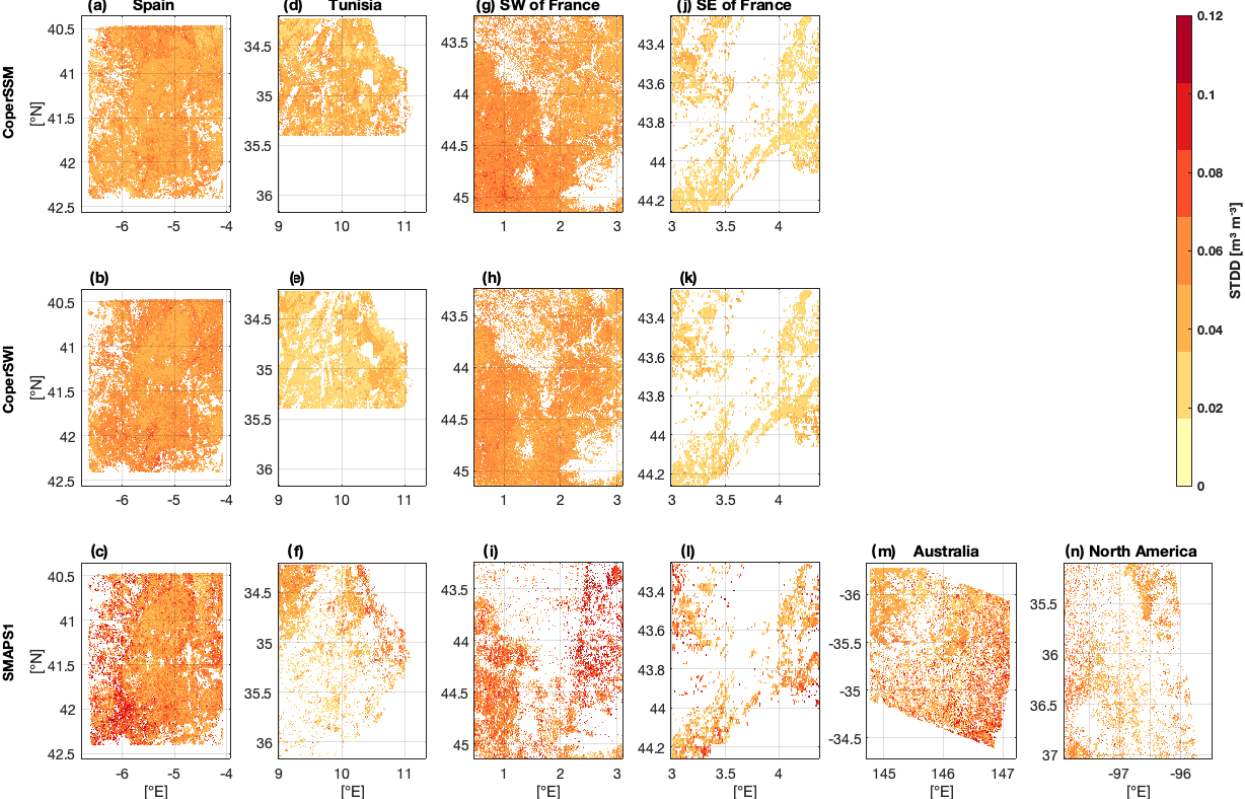
Figure 6. Comparison of S 2 MP S1S3 with respect to CoperSSM, CoperSWI, and SMAPS1 over the regions of study in terms of standard deviation of the difference (SDD; in m 3 m − 3 ). The analysis was performed from January to December